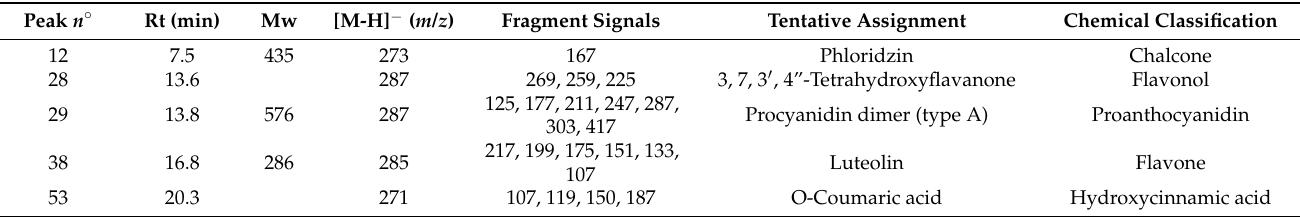
Table 4. Major phytochemical compounds identified in the sapwood extract (SE).